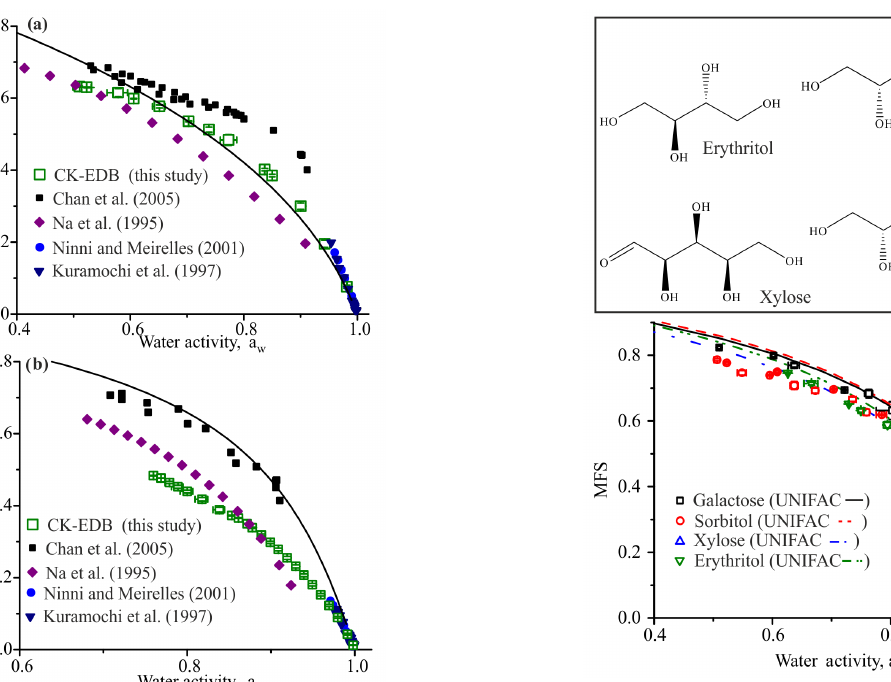
Figure 9. Equilibrium hygroscopicity data for (a) glycine and (b) alanine. The solid black line is the UNIFAC model prediction for alanine and glycine, generated using E-AIM model III.